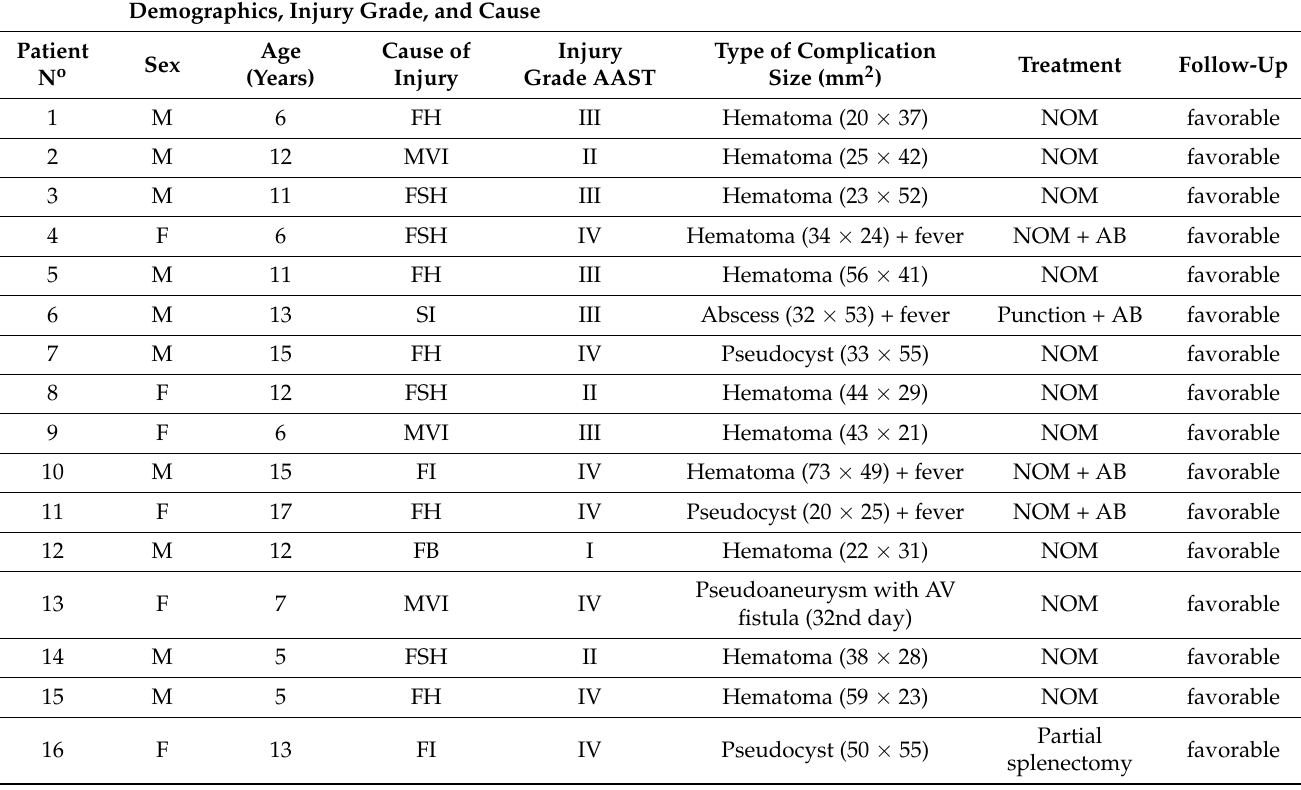
Table 3. Details of various complications in patients treated with NOM after blunt trauma of the spleen. Demographics, Injury Grade, and